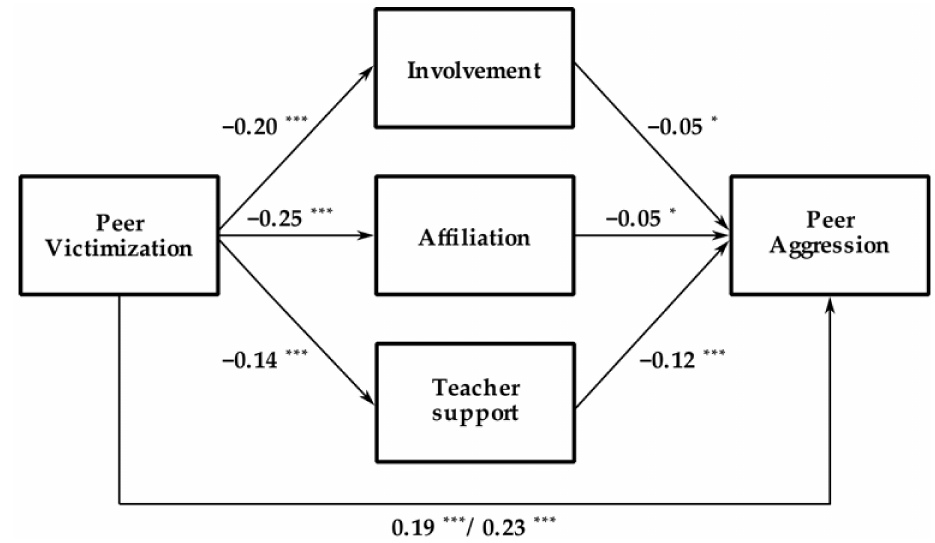
Figure 2. Illustration of the resulting model with the values obtained in the analysis of the mediation role of the three classroom climate dimensions on the relationship between peer victimization and peer aggression. *: p < 0.05, ***: p <